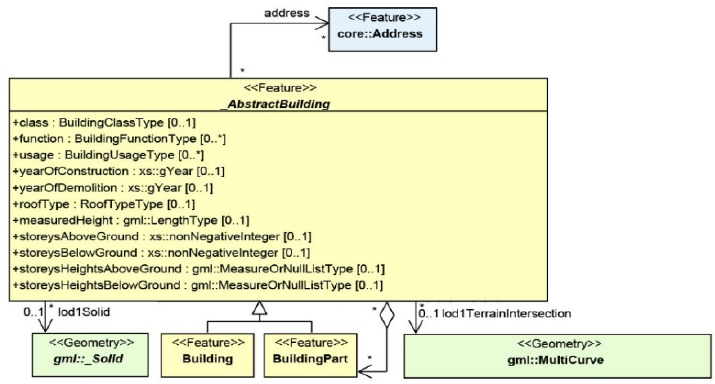
Figure 10. UML diagram of the implemented CityGML objects and features.